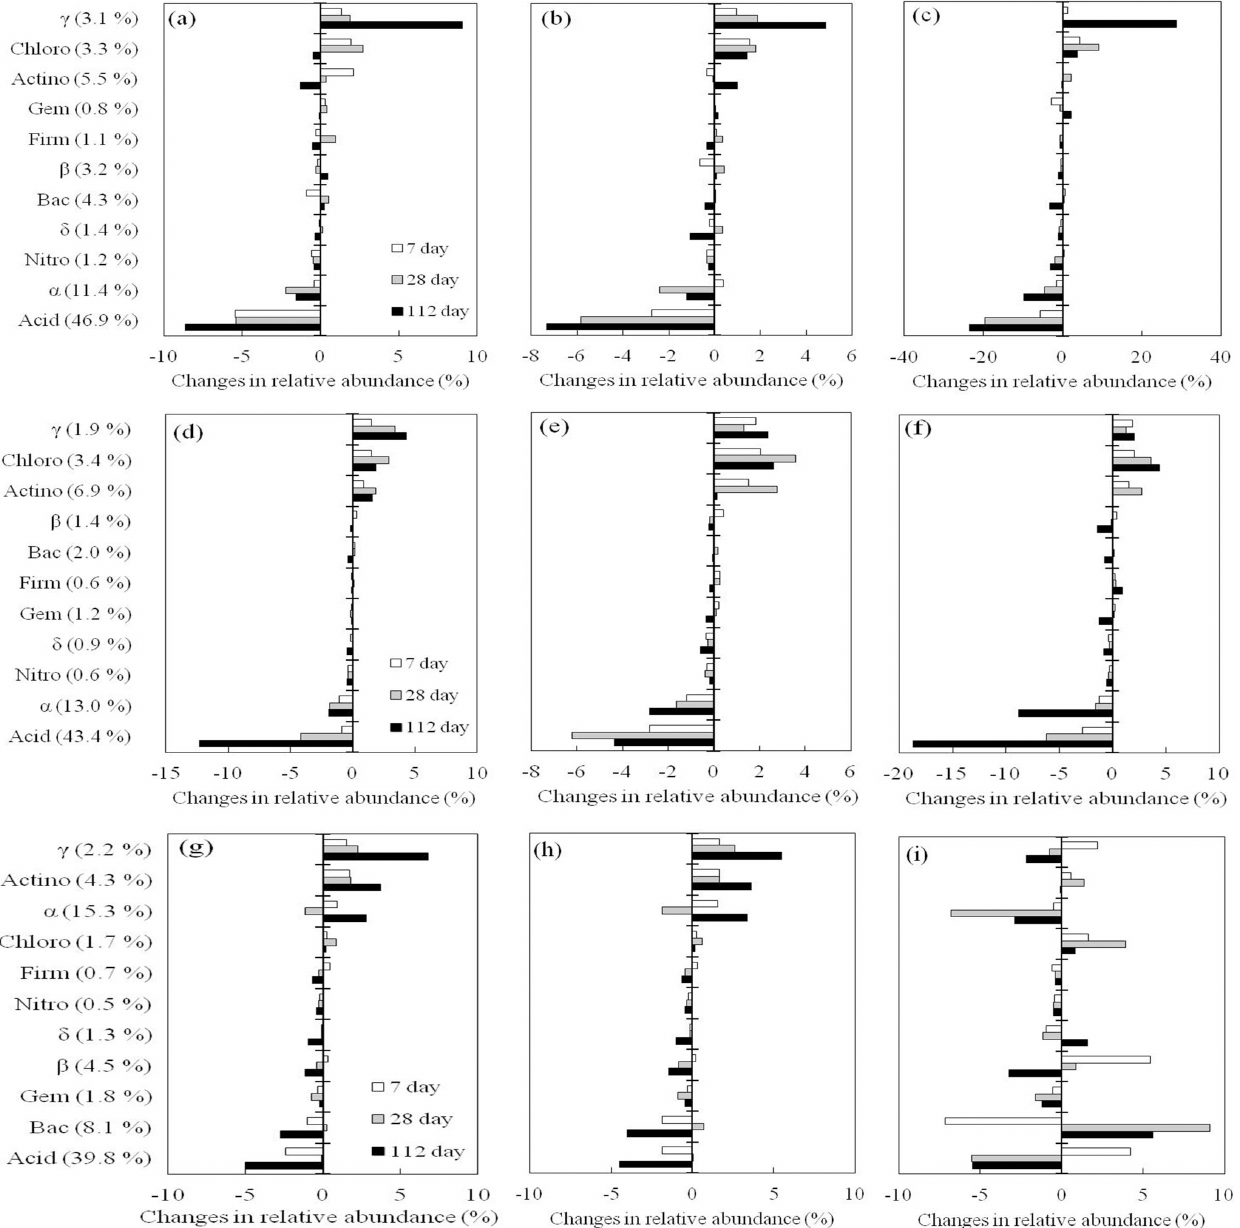
Figure 4. Changes in relative abundance of phylogenetic groups of bamboo soil bacterial communities at (a) 600m, 15 ◦ C; (b) 600m, 20 ◦ C; (c) 600m, 35 ◦ C; (d) 1200m, 15 ◦ C; (e) 1200m, 20 ◦ C; (f) 1200m; 35 ◦ C, (g) 1800m, 15 ◦ C; (h) 1800m, 20 ◦ C; and (i) 1800m, 35 ◦